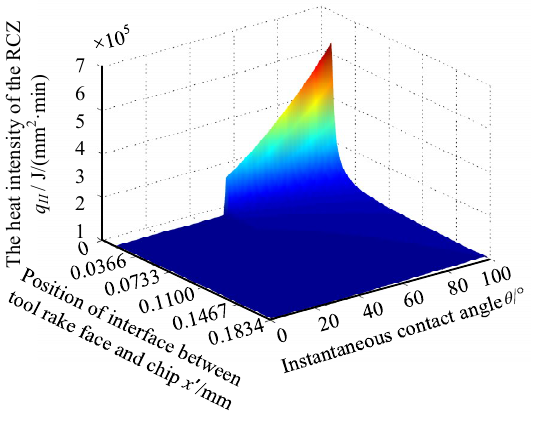
Figure 20. The heat intensity in the RCZ.